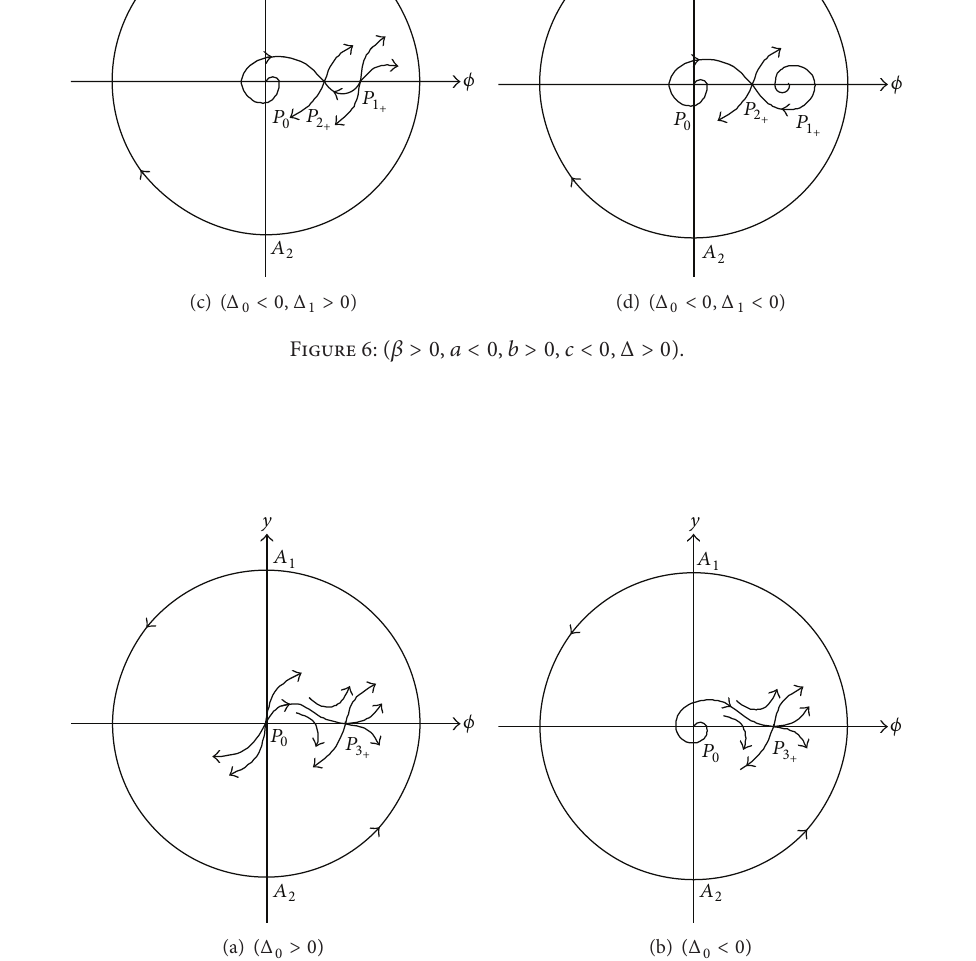
Figure 7: ( 𝛽 > 0 , 𝑎 < 0 , 𝑏 > 0 , 𝑐 < 0 , Δ = 0